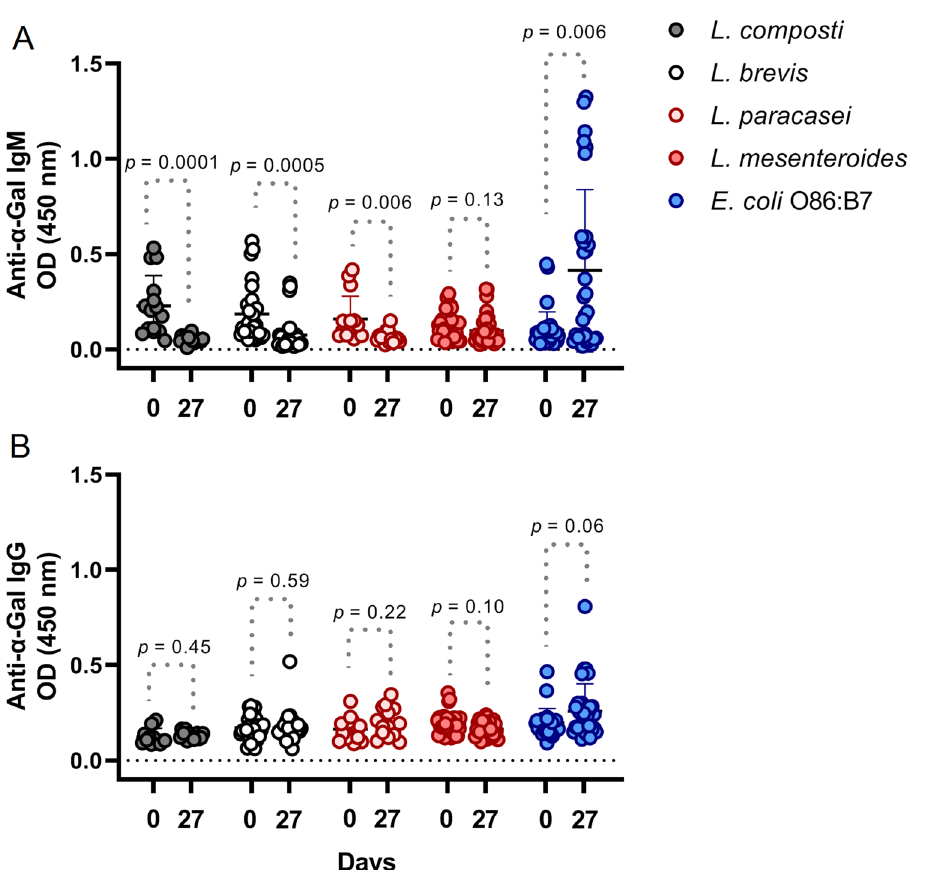
Figure 4. Oral administration of E. coli O86:B7 increased anti-Galα1-3Gal IgM antibody response in sera α1,3GT KO mice. Anti Galα1-3Gal IgM levels increased on α1,3GT KO mice more than the measured value in mice treated with L. brevis (LBH1073), L. composti (LBH1074), L. paracasei (LBH1146), and L. mesenteroides (LBH1148) by day 27. ( A ) No change was observed on IgG response against Galα1-3Gal antigen. ( B ) The levels of circulating anti-α-Gal IgM and IgG were measured by ELISA. Results shown are means and standard deviation values, IgM was significant at p < 0.05, p < 0.001, p < 0.0001; while IgG was not statistically significant, 2 experiments, n = 30 and three technical replicates per